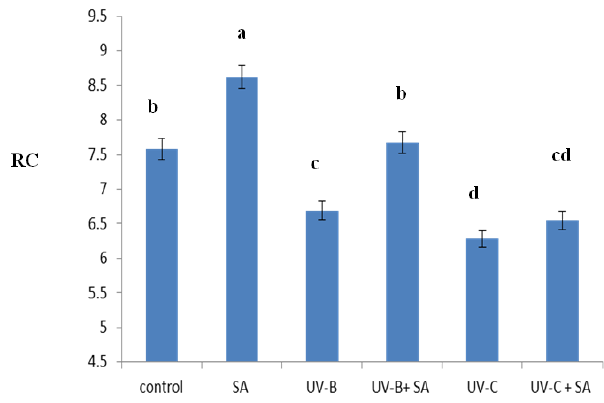
Fig. 2. Rehydration characteristic (RC) affected by various treatments in Satureja hortensis L. Data represent means of three replicates represented by standard division. Different letters between treatments denote significant differences (Duncan test, P <